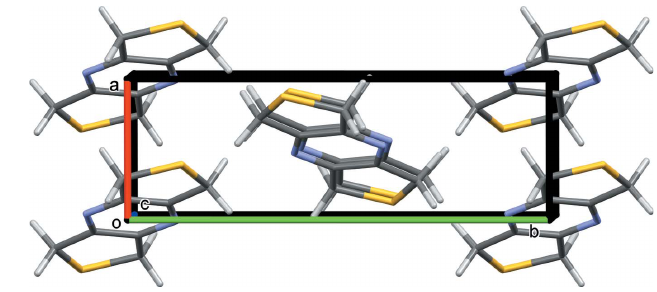
Figure 5 Crystal packing of L1 viewed along the c axis. The molecules stack in columns up the a